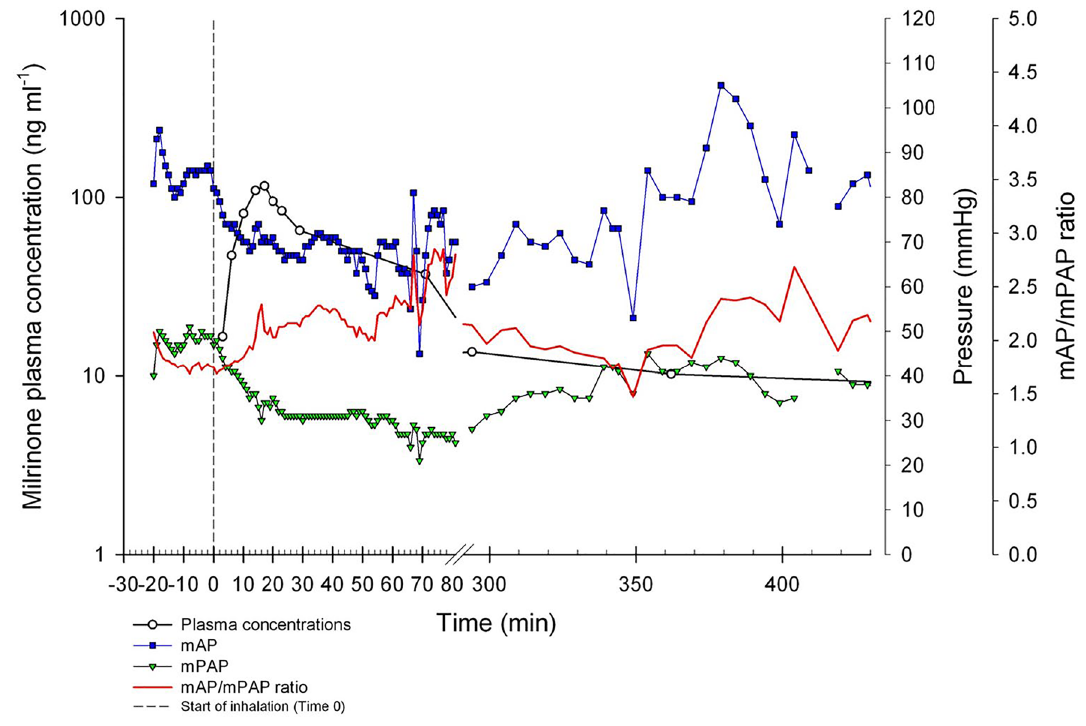
Figure 2. Typical plasma concentration–time profile and effect-time profile for one patient. mAP mean arterial pressure, mPAP mean pulmonary arterial pressure.